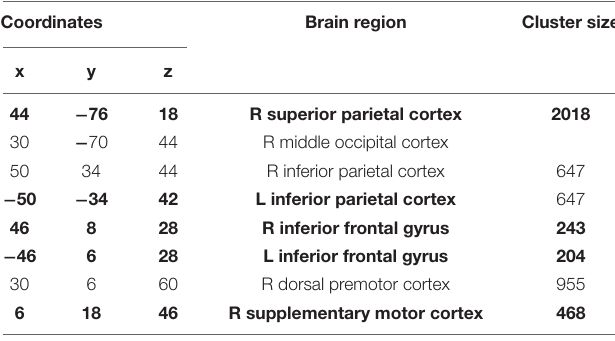
Bold values: correction for multiple comparisons used the FWE method at a corrected p < 0 . 05.